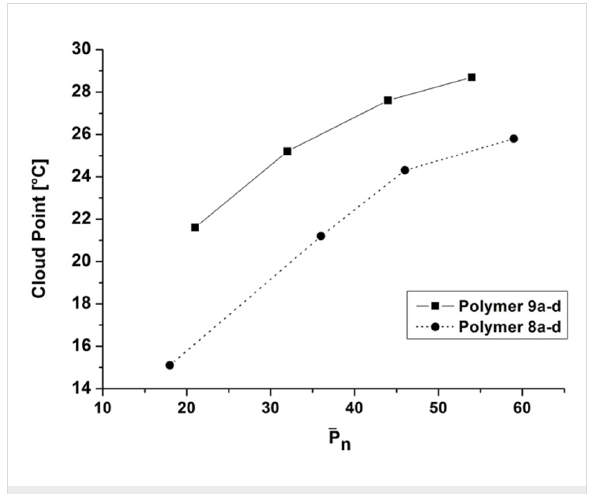
Figure 4: Dependency of the cloud point values on the degree of poly- merization (calculated by end-group analysis based on 1 H NMR